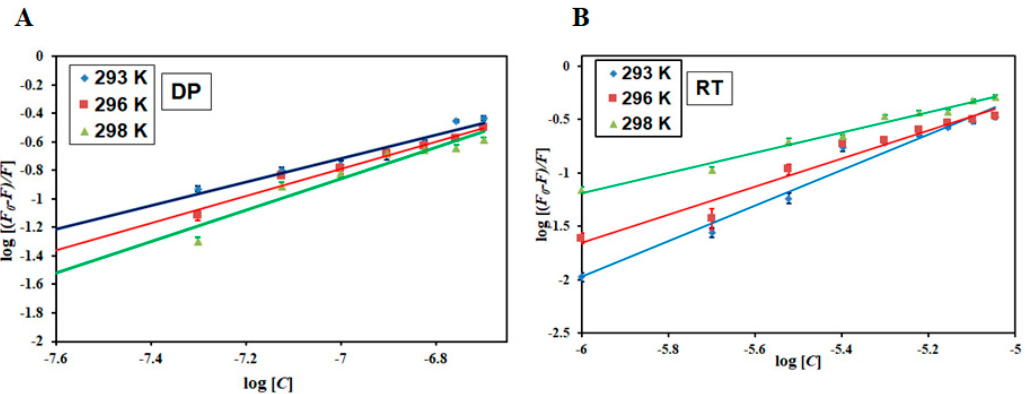
Figure 3. Modified Stern − Volmer plots of (A) MARK4 − DP and (B) MARK4 − RT at three different temperatures.